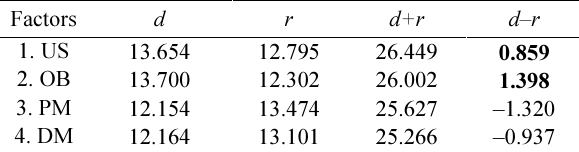
Table 11. Degree of total influence of factors